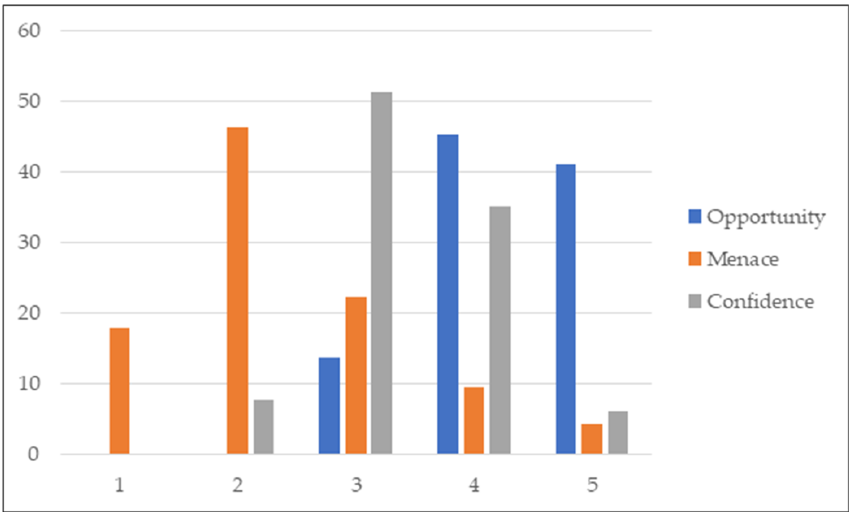
Figure 6. Evaluation of AI segmentation solutions per menace, opportunity and confidence scales.